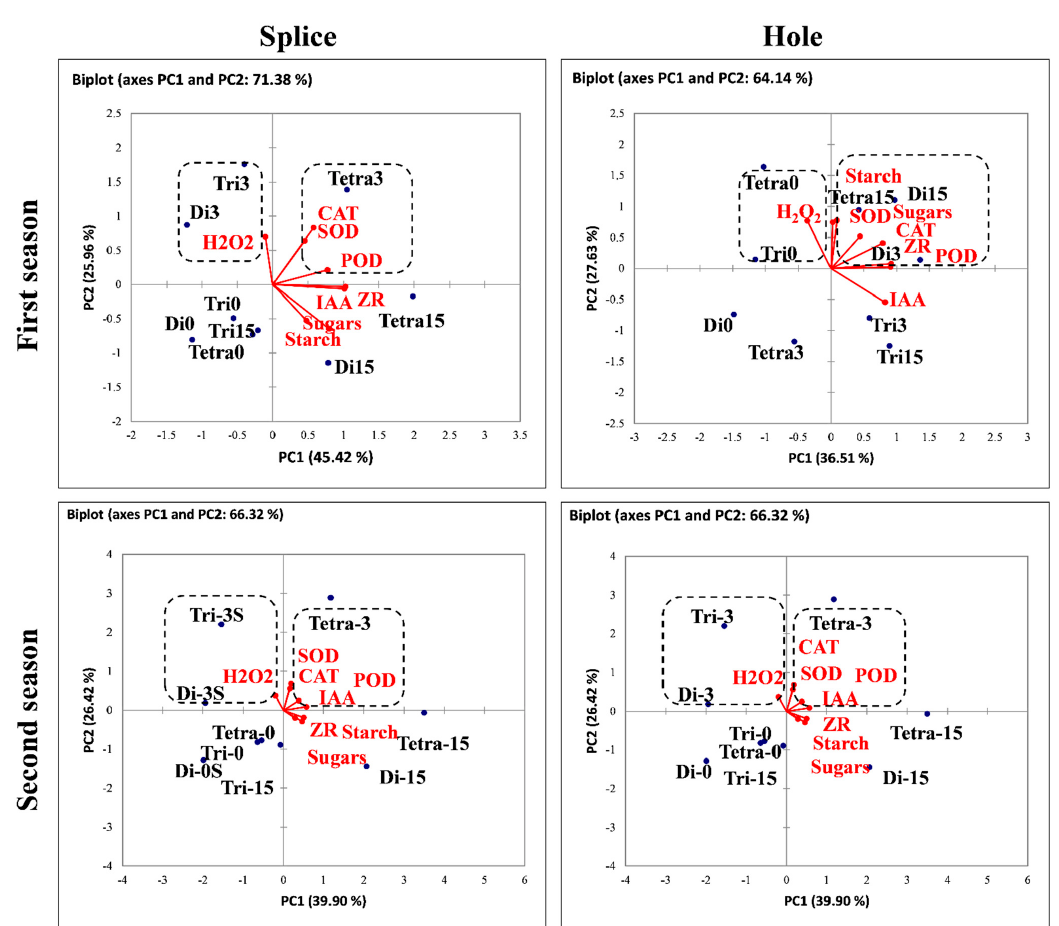
Figure 10. Principal Component Analysis (PCA) scatterplot based on total concentrations of the AOX, Hormones, starch, and sugars as a function of the grafting combination in Di, Tri, and Tetra watermelon at three stages (0, 3, 15 DAG). Di: Diploid, Tri: triploid, Tetra: Tetraploid.